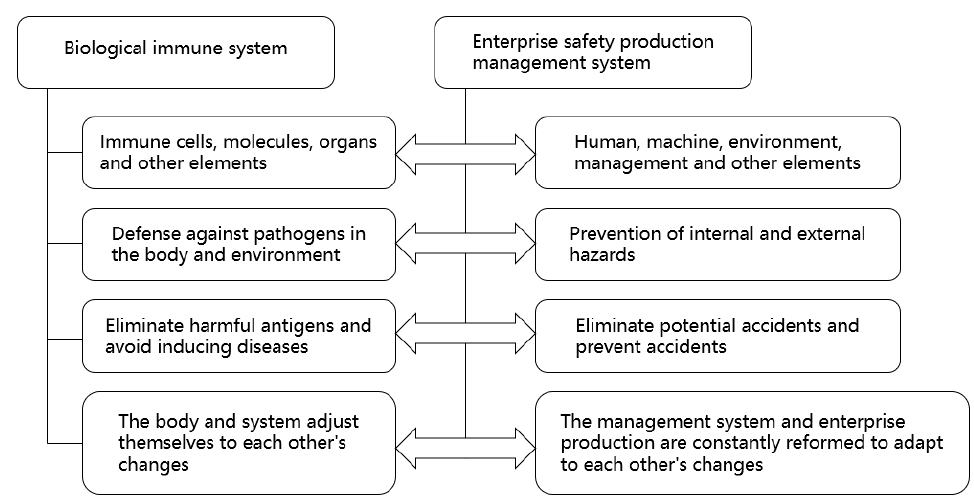
Figure 1. Correlation between immune system and enterprise security management system.